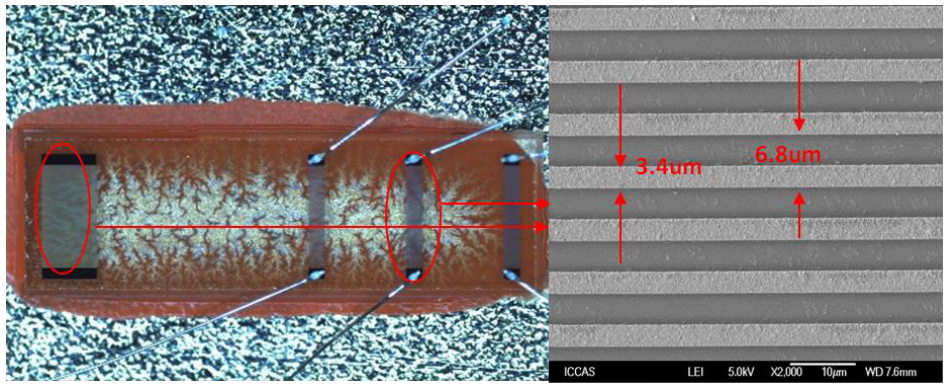
Figure 4. The physical picture of sensor chip that was developed.